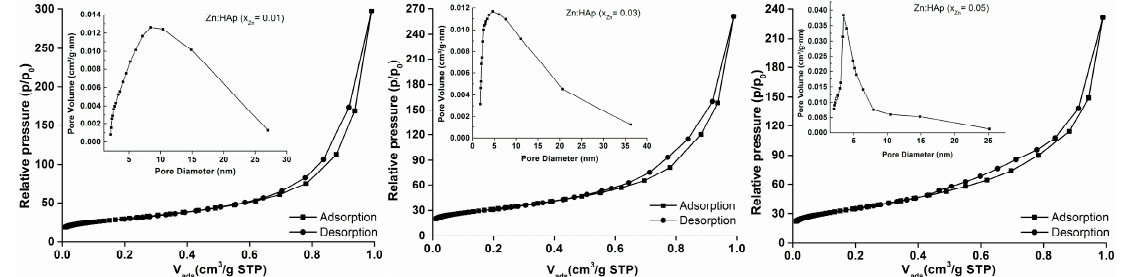
Figure 6. Textural characteristics of the Zn:HAp, Ca 10 − x Zn x (PO 4 ) 6 (OH) 2 samples synthesized with 0.01 ≤ x Zn ≤ 0.05 using N 2 adsorption–desorption isotherms and the pore size distribution curves.